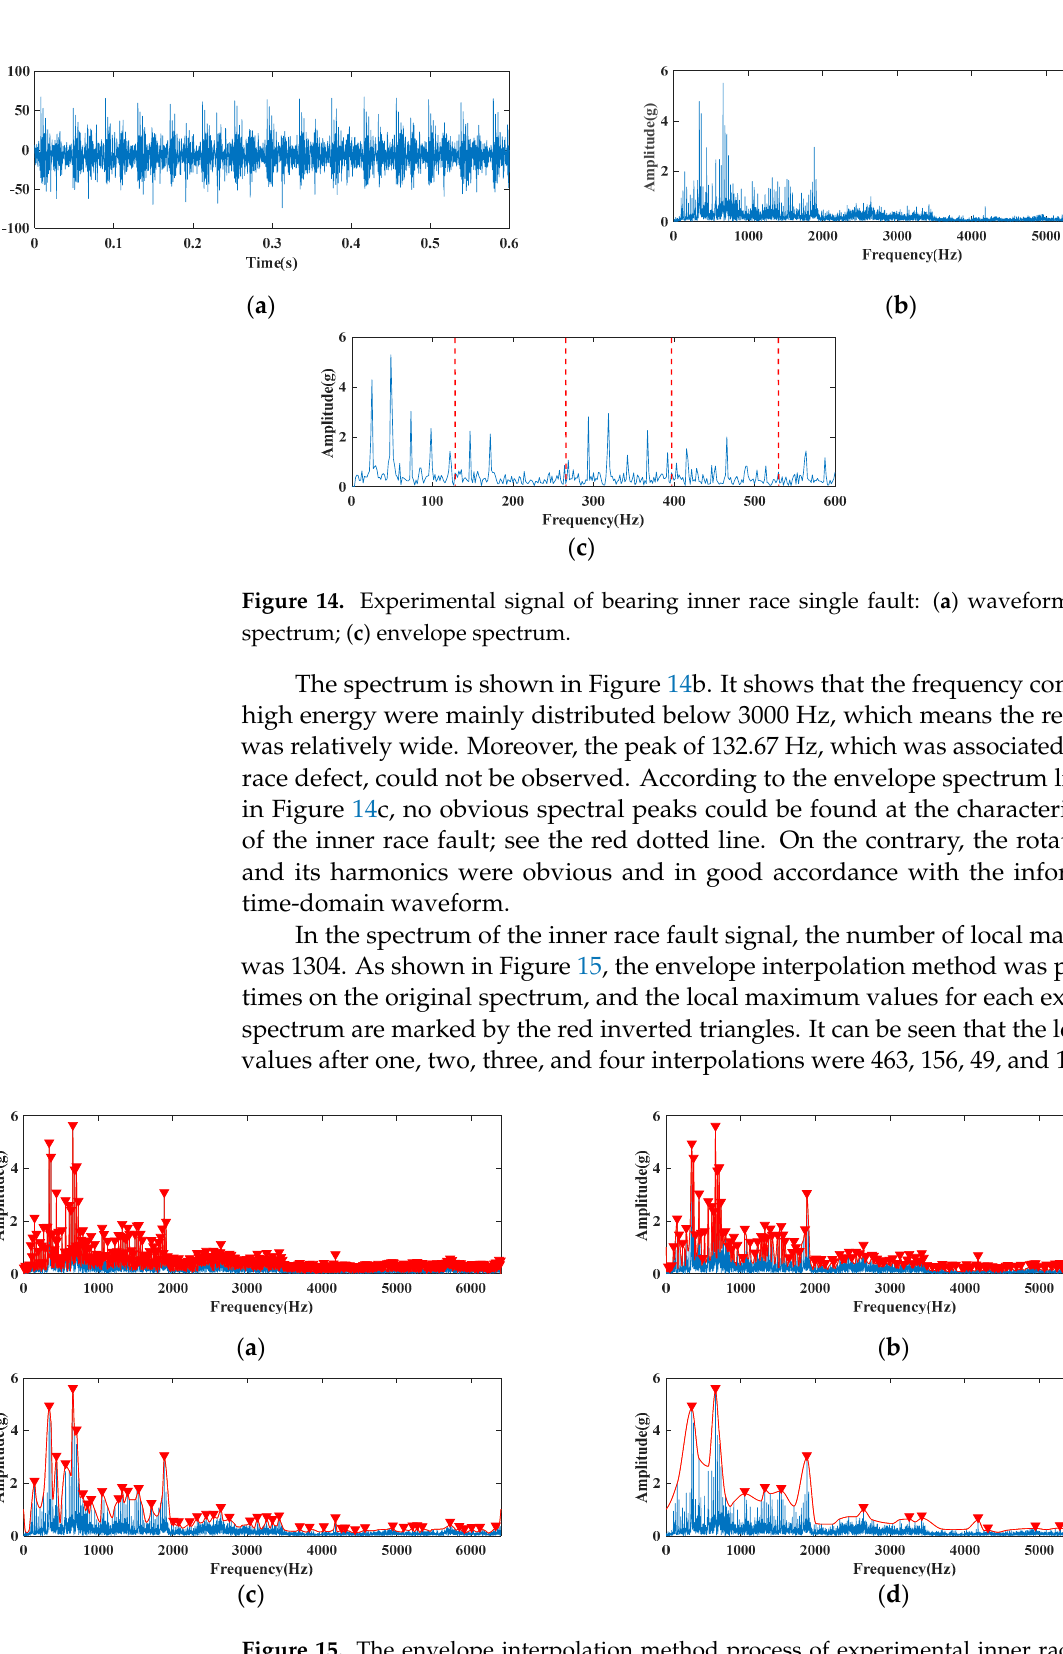
Figure 15. The envelope interpolation method process of experimental inner race failure signal: ( a ) 1st time execution; ( b ) 2nd time execution; ( c ) 3rd time execution; ( d ) 4th time execution.